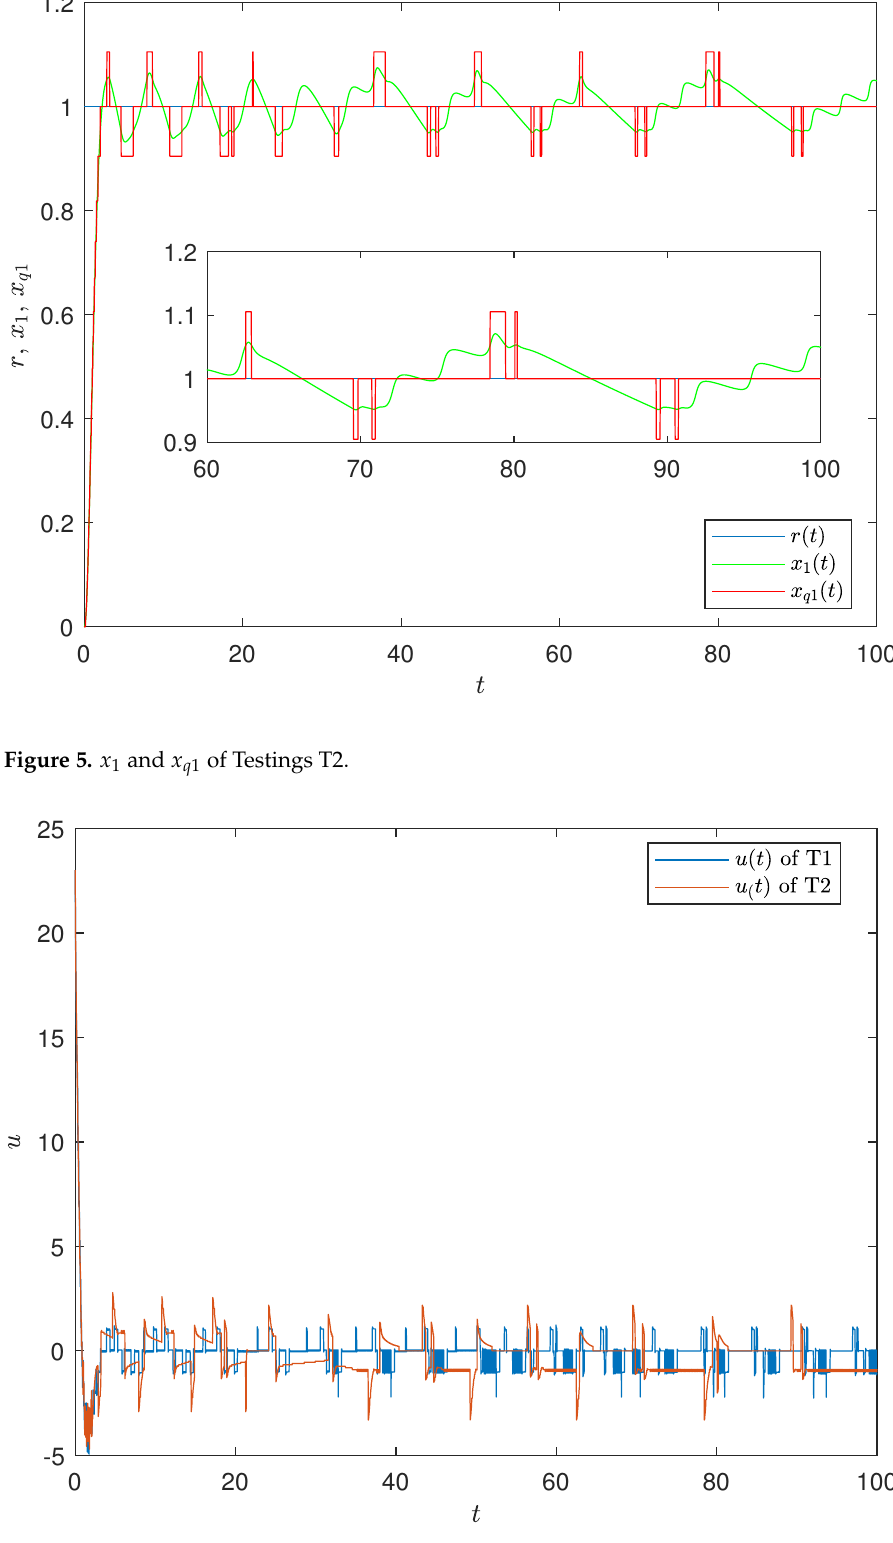
Figure 6. The input signals of Testings